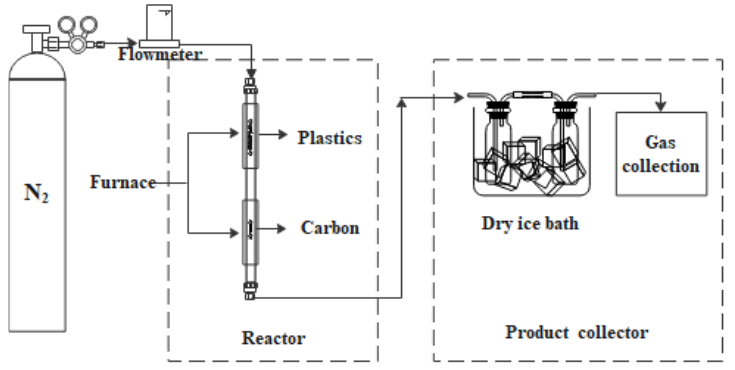
Figure 1. Catalytic pyrolysis setup.